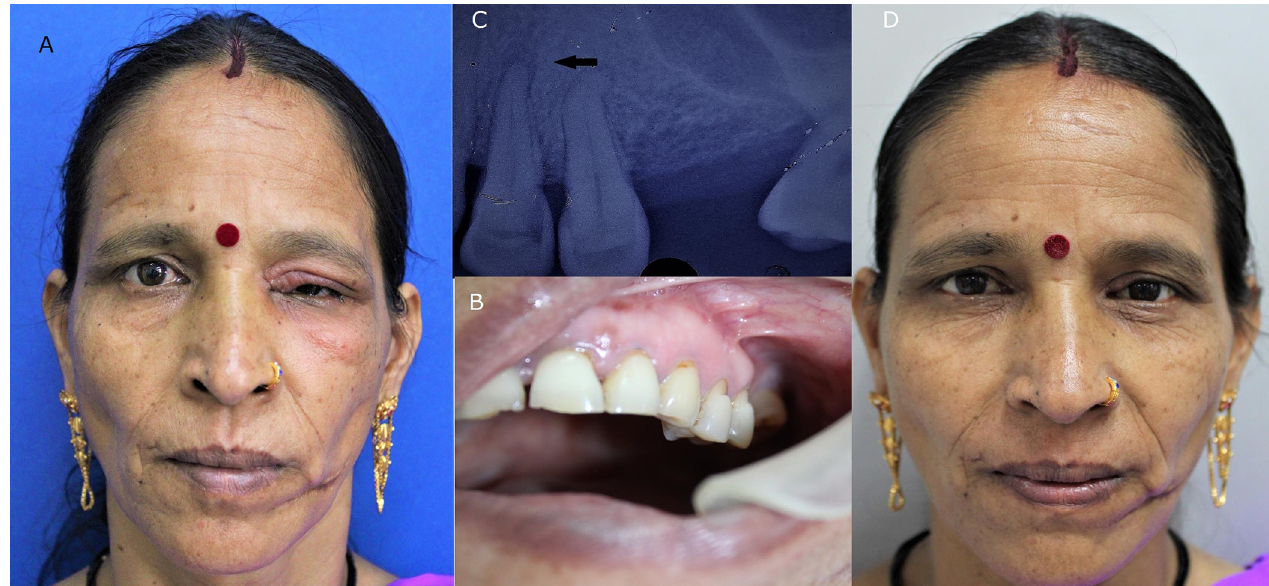
Fig. 1. Periorbital cellulitis of left eye (A), Periapical abscess associated with left premolars (B), IOPA showing carious 1st premolar associated with periapical radiolucency (C), complete recovery following extraction of carious teeth